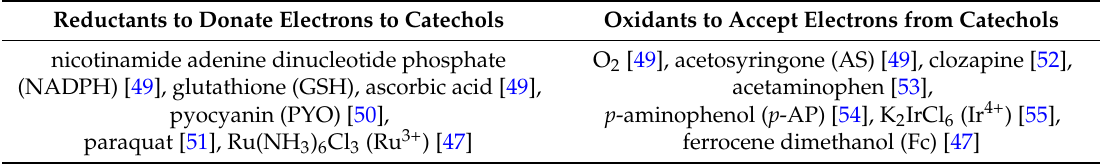
Table 1. Tested redox chemicals that can redox-interact with catechol–chitosan films. Reductants to Donate Electrons to Catechols Oxidants to Accept Electrons from Catechols nicotinamide adenine dinucleotide